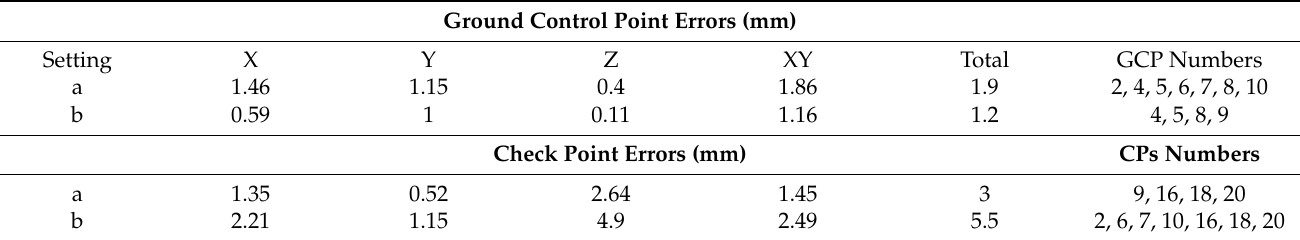
Table 1. RMS errors for the GCPs and CPs for different comparison